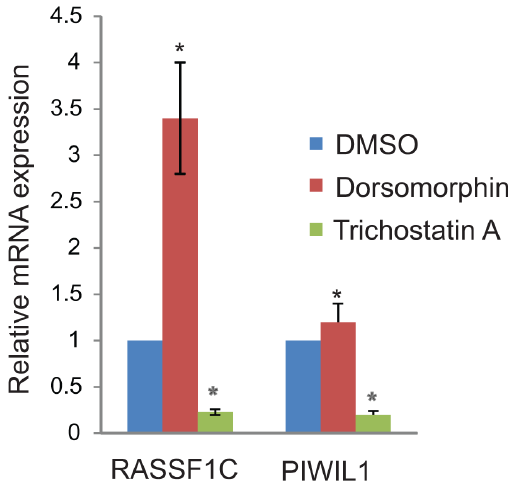
Figure 10 . Dorsomorphin and Trichostatin A have opposite effects on RASSF1C and PIWIL1 gene expression . H1299 lung cancer cells were treated with Dorsomorphin and Trichostatin A at a concentration of 10 m M to validate the PCR array data. RT-PCR analysis shows that Dorsomorphin significantly up-regulated RASSF1C gene expression while slightly up-regulating PIWIL1 gene expression. Trichostatin A treatment significantly down-regulated RASSF1C and PIWIL1 mRNA levels. The data presented is an average of three independent RT-PCR experiments done in triplicate, * = P , 0.05.